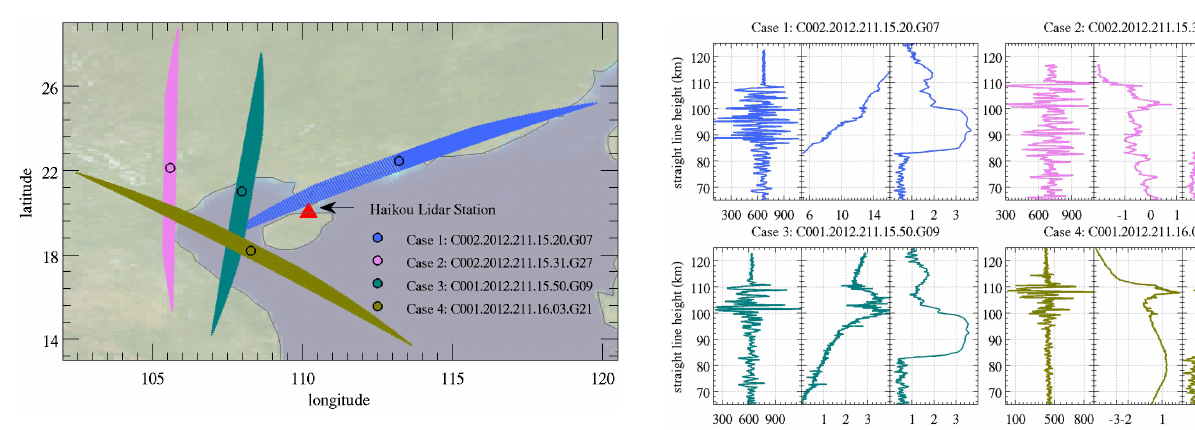
Figure 6. The red triangle represents the location of Haikou lidar station over China. The shaded areas show the E s occurrence area (EOA) for the four colocated RO events observed by COSMIC, rep- resented by four colors. The points at which the straight line height is 100km are marked by the black circles.